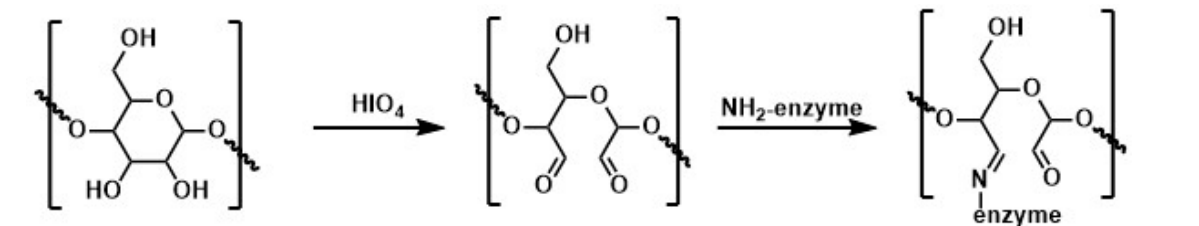
Figure 23. Scheme of dialdehyde cellulose synthesis and enzyme immobilization.